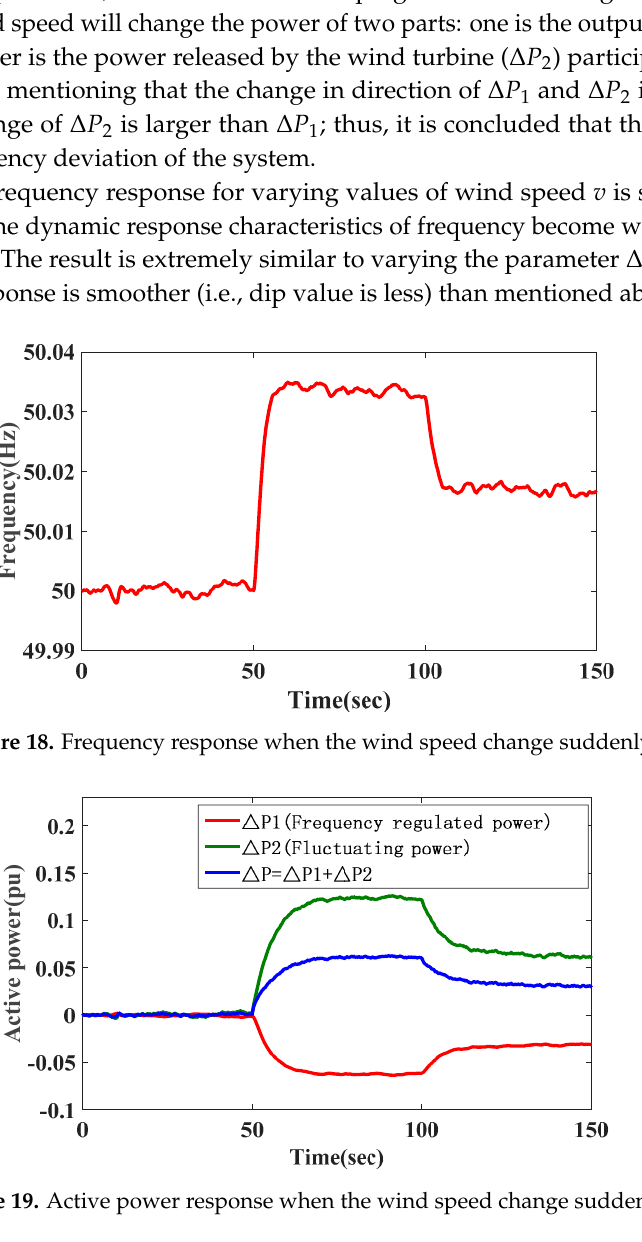
16 of 19 Figure 17. Wind speed variations with sudden disturbance.